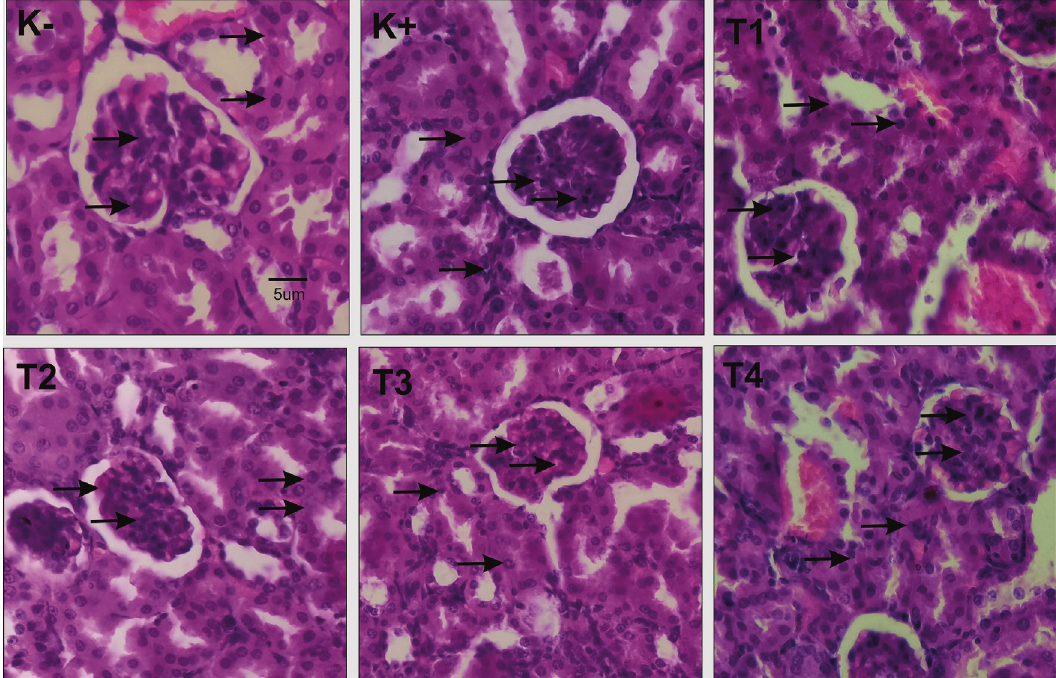
FIGURE 2 - Normal and necrosis cell glomerular and tubules in kidney, staining using Hematoxylin-Eosin. Arrow = necrosis cell and normal cell (400 X